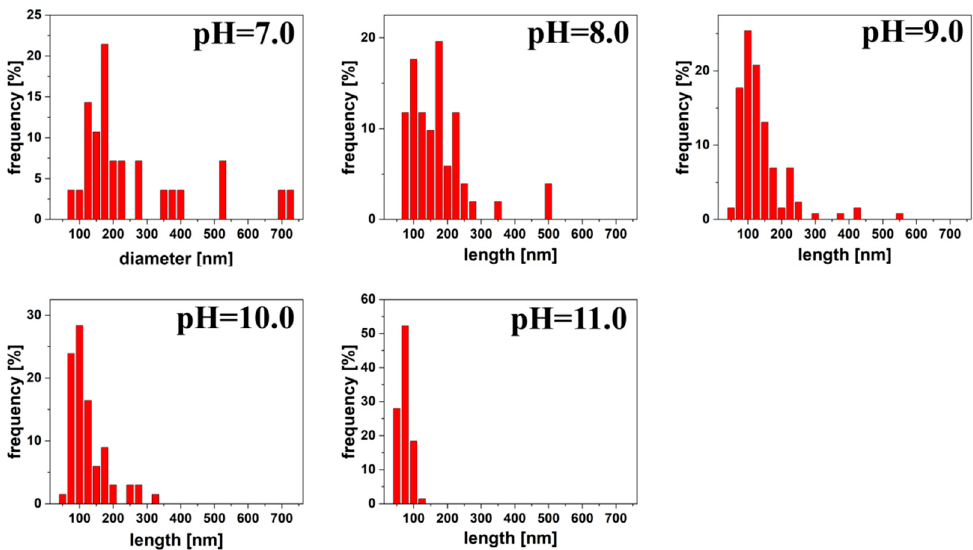
Figure 4. Distribution of rods length for silver colloids reduced by citric acid at pH 7.0 to 11.0.